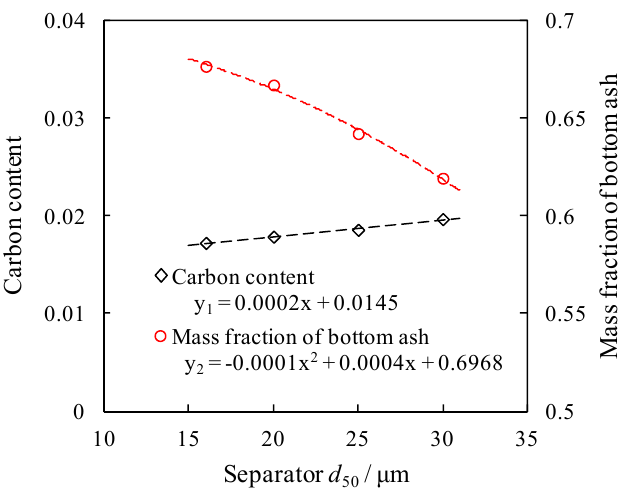
Figure 16. E ff ect of separator e ffi ciency on Figure 16. Effect of separator efficiency on combustion.